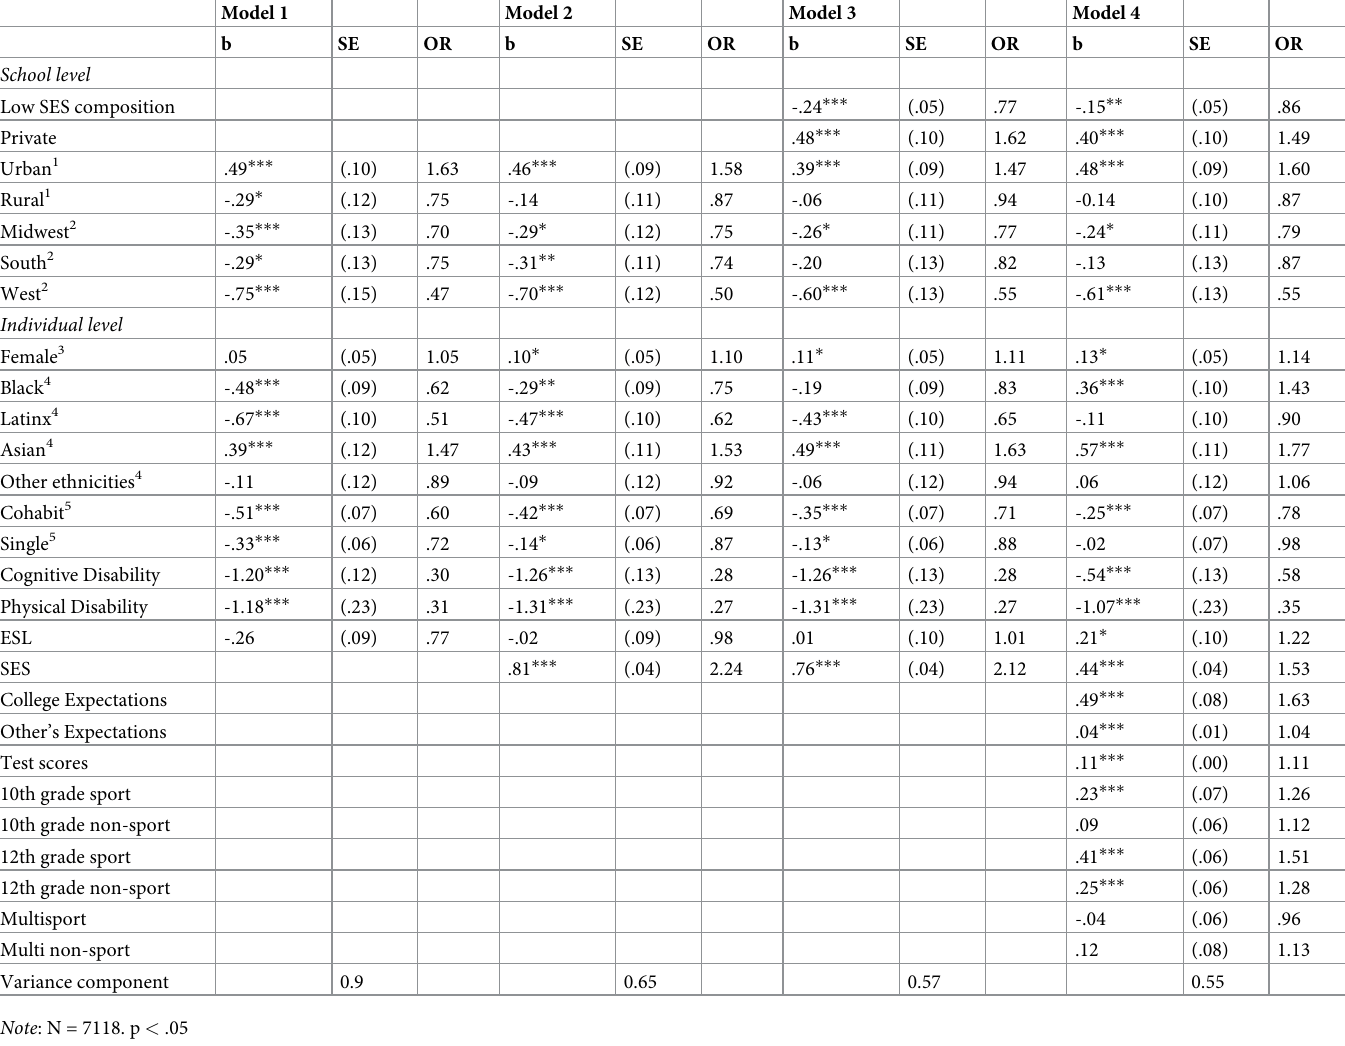
Table 3. Multilevel ordinal logistic regressions predicting college students’ likelihoods of enrolling at a more selective school. Model 1